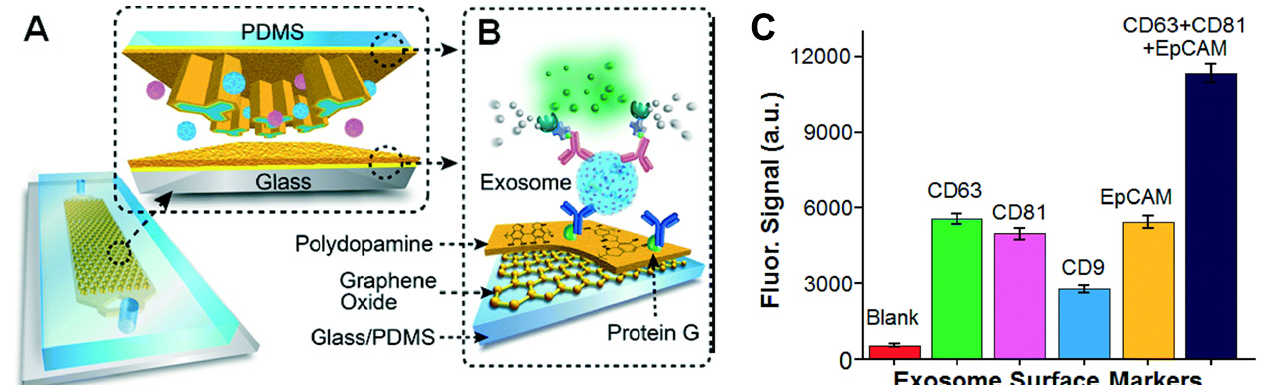
Figure 8. ( A ) Schematics of microfluidics platform based on graphene oxide/polydopamine nano-interface (nano-IMEX) for exosome immunocapture; ( B ) detection of exosomes surface markers via sandwiched ELISA. ( C ) Exosome surface marker profiling of COLO-1 cell exosomes (10 6 µL − 1 ) captured by CD81 mAb. Reproduced with permission from Zhang et al., 2016 under Creative Commons Attribution Non-Commercial 3.0 Unported License, Copyright 2016, Royal Society of Chemistry.